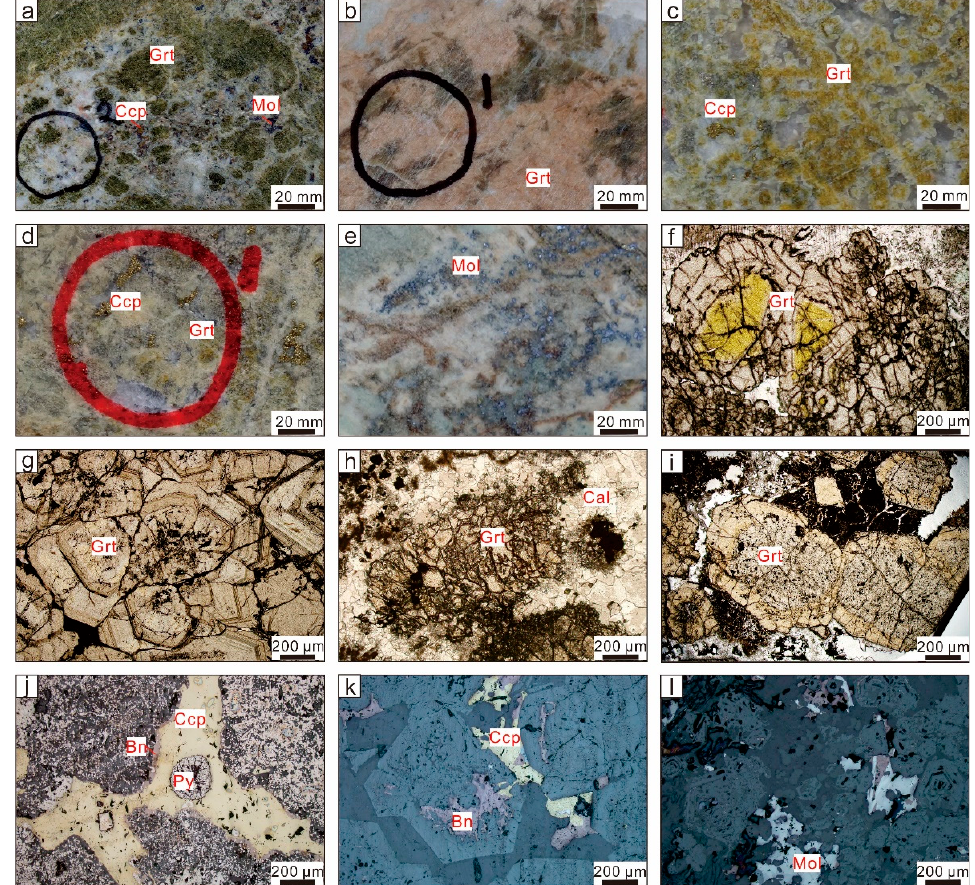
Figure 2. Hand specimen photos and microphotographs from the No. 24 exploration line in Jiama deposit. ( a ) Green garnet. ( b ) Red brown garnet. ( c ) Yellow green garnet. ( d ) Disseminated chalcopyrite. ( e ) Vein-shaped molybdenite. ( f ) Granular garnet. ( g ) Zoned garnet. ( h ) Broken garnet. ( i ) Vein-shaped garnet. ( j ) Chalcopyrite, bornite, pyrite symbiosis. ( k ) Chalcopyrite, bornite are filled in the garnet gaps and fissures. ( l ) Molybdenite filled in garnet gaps. Grt: garnet; Ccp: chalcopyrite; Mol: molybdenite; Cal: calcite; Py: pyrite; Bn: bornite.